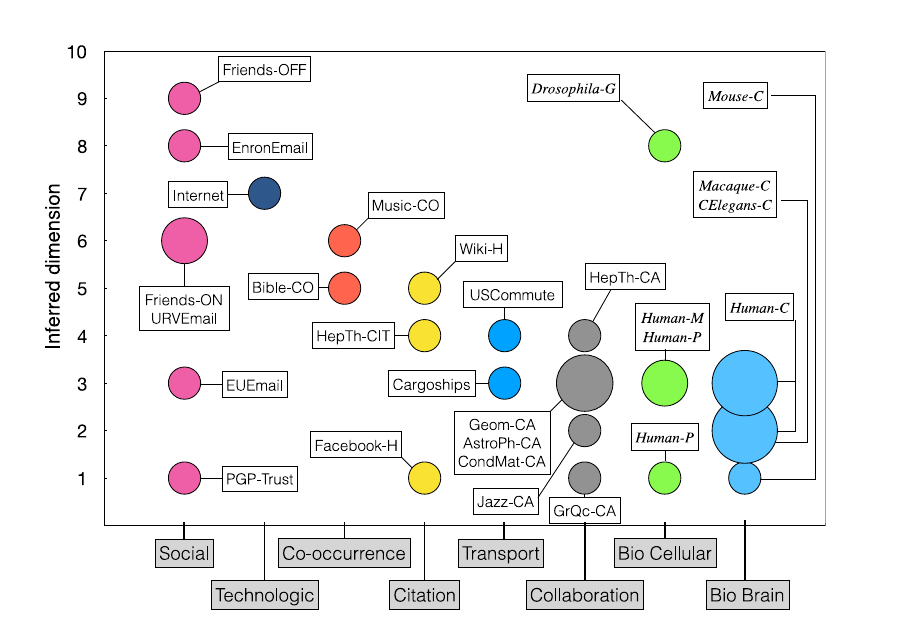
Fig. 5 | Dimensions of real networks by category. The size of the symbol is proportional to the number of networks with the same dimension.